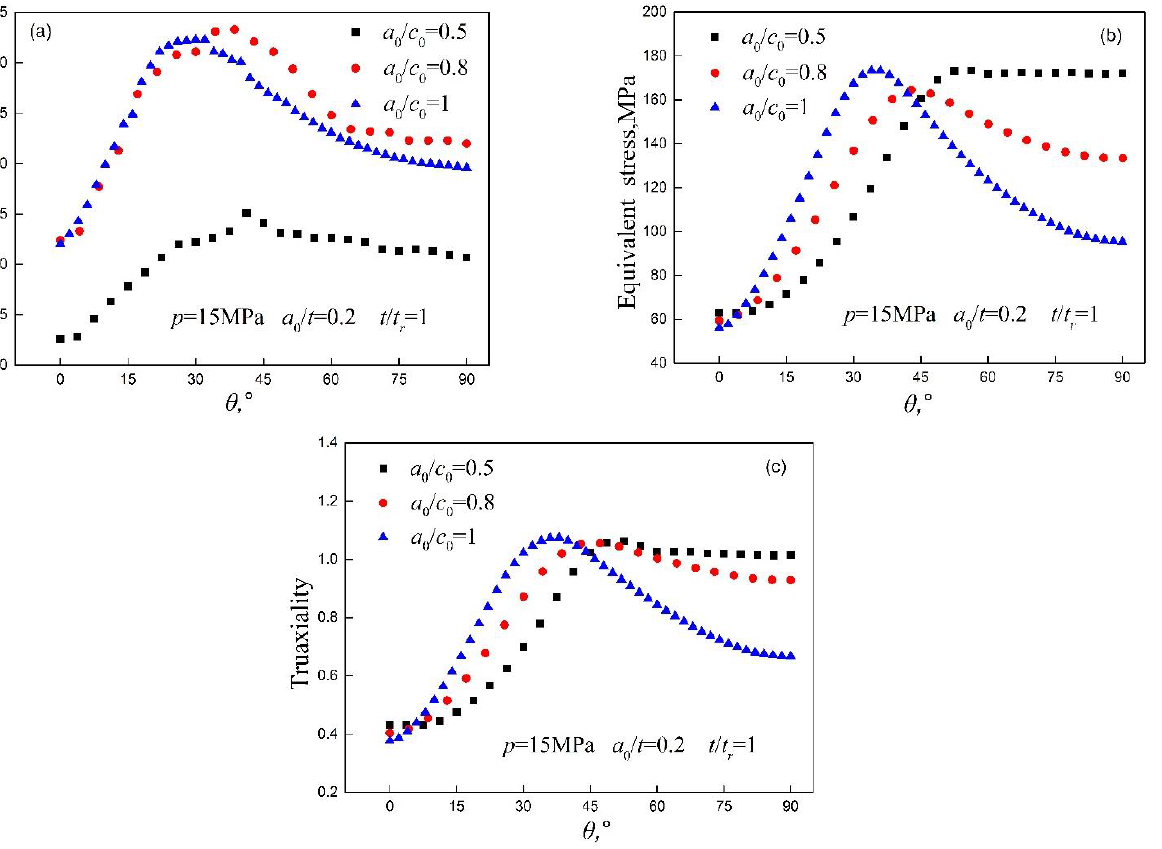
Figure 18. The relationship between the ( a ) creep crack length, ( b ) equivalent stress, ( c ) triaxiality and θ . and θ